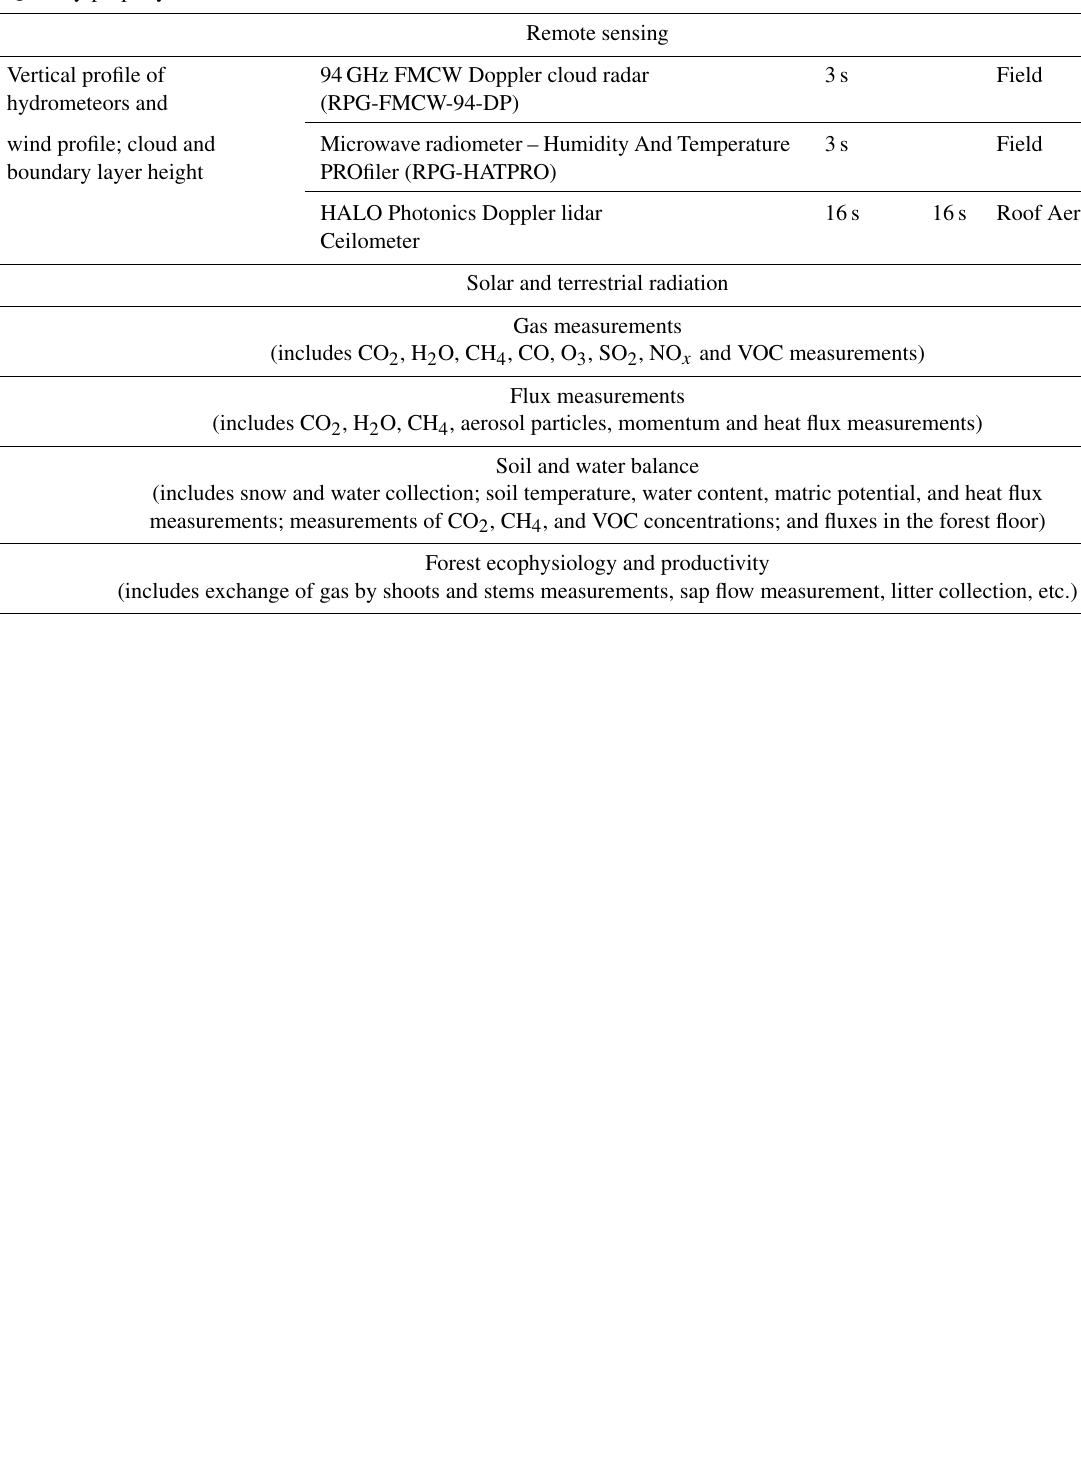
Table A3. Part 3: overview of the SMEAR II instrumentation running throughout the HyICE-2018 campaign. Quantity/property